Question: According to the figure, is the described quantity increasing or decreasing?
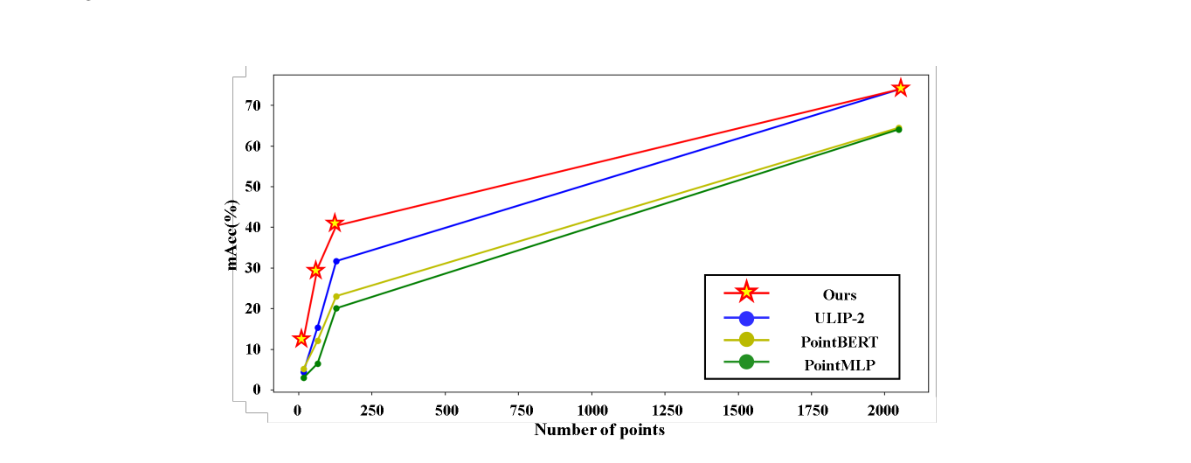
Answer: increasing